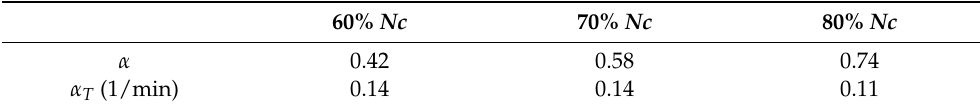
Table 4. Values of the kinetic parameters α , α T for different mill